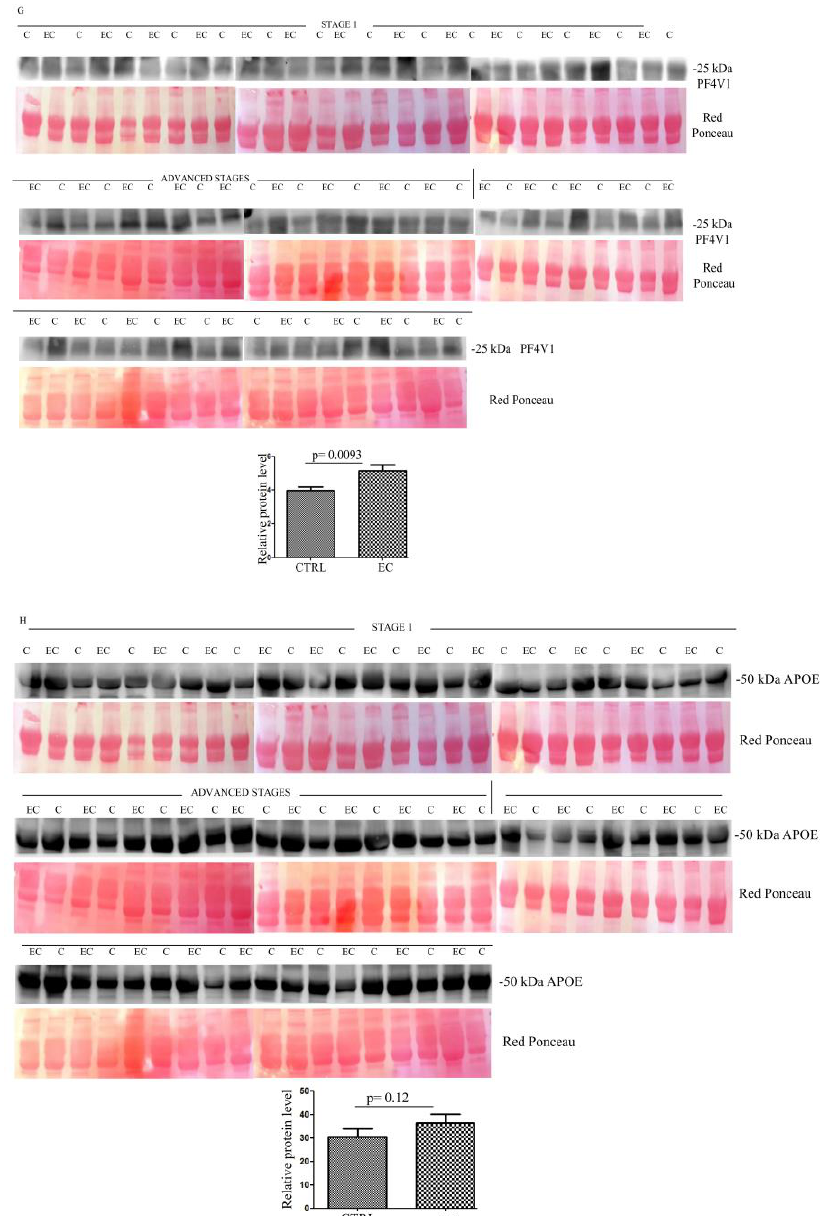
Figure 2. (A – H) Western blotting analyses of exosomes for eight proteins APOA1, HBB, CA1, HBD, LPA, SAA4, PF4V1, and APOE in controls (C) and endometrial cancer (EC) patients. The intensity of immunostained bands was normalized against the total protein intensities measured from the same blot stained with Red Ponceau. The graph shows the relative abundance of the proteins in control and endometrial cancer exosomes. Results are shown as a histogram ( p < 0.05), with each bar representing mean ± standard deviation.